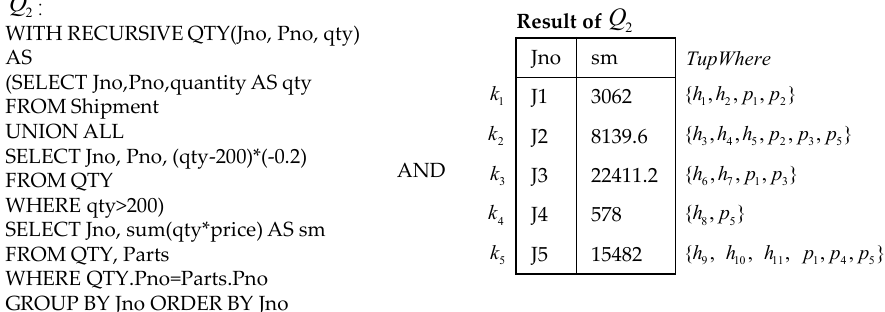
Figure 3. The query 𝑄 (cid:2870) and its output tagged with tuple-level where-prov.